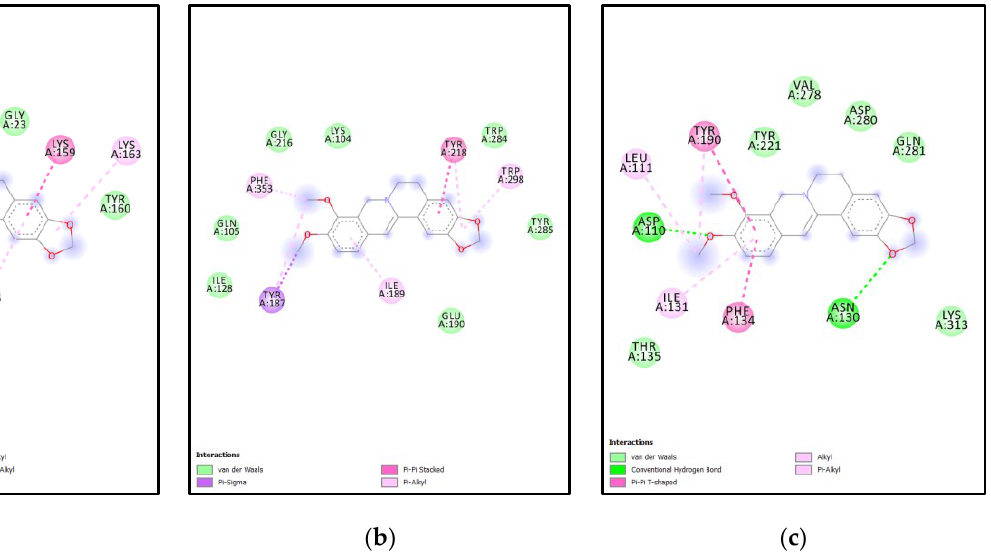
Figure 11. Ligplot showing amino acid residues involved in ligand-protein interaction for ( a ) Yeast-Berberine interacting amino acid residues ( b ) XP-Berberine interacting amino acid residues ( c ) XM-Berberine interacting amino acid residues.